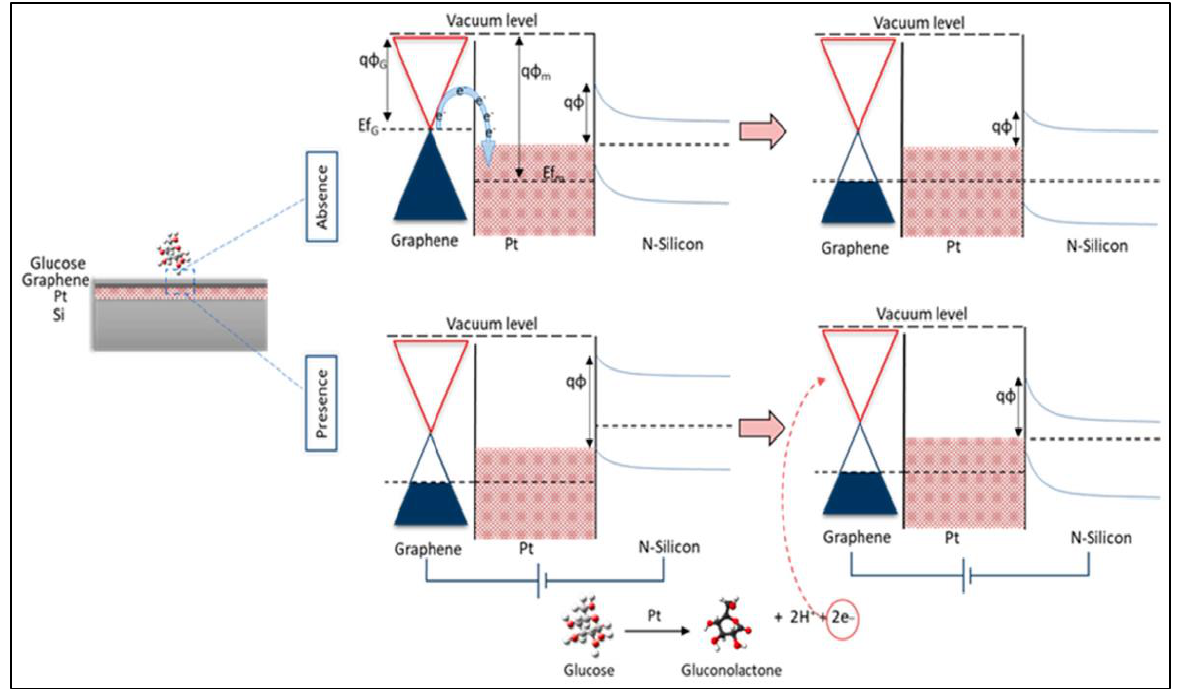
Figure 8. Graphene (G)/platinum oxide (PtO)/n-silicon (Si) heterostructure based glucose sensor working principle. Reprinted Ref. [70].